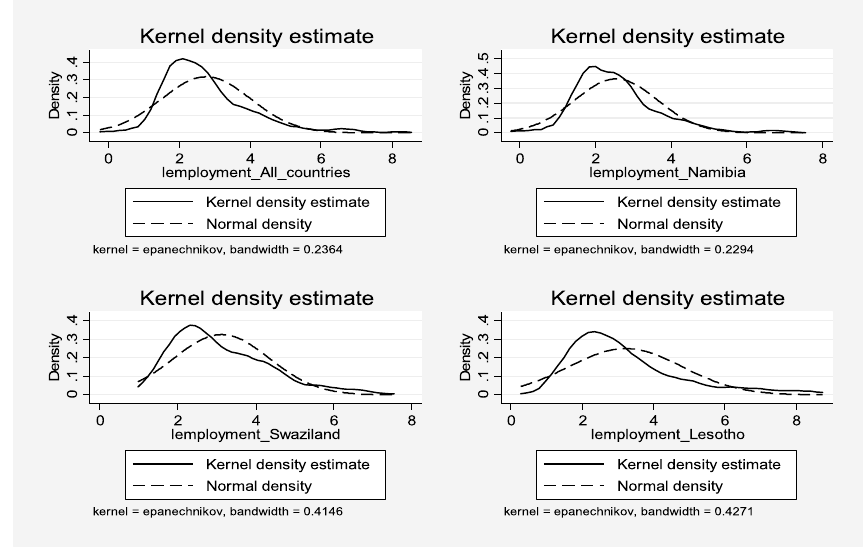
Fig. 1 Kernel density